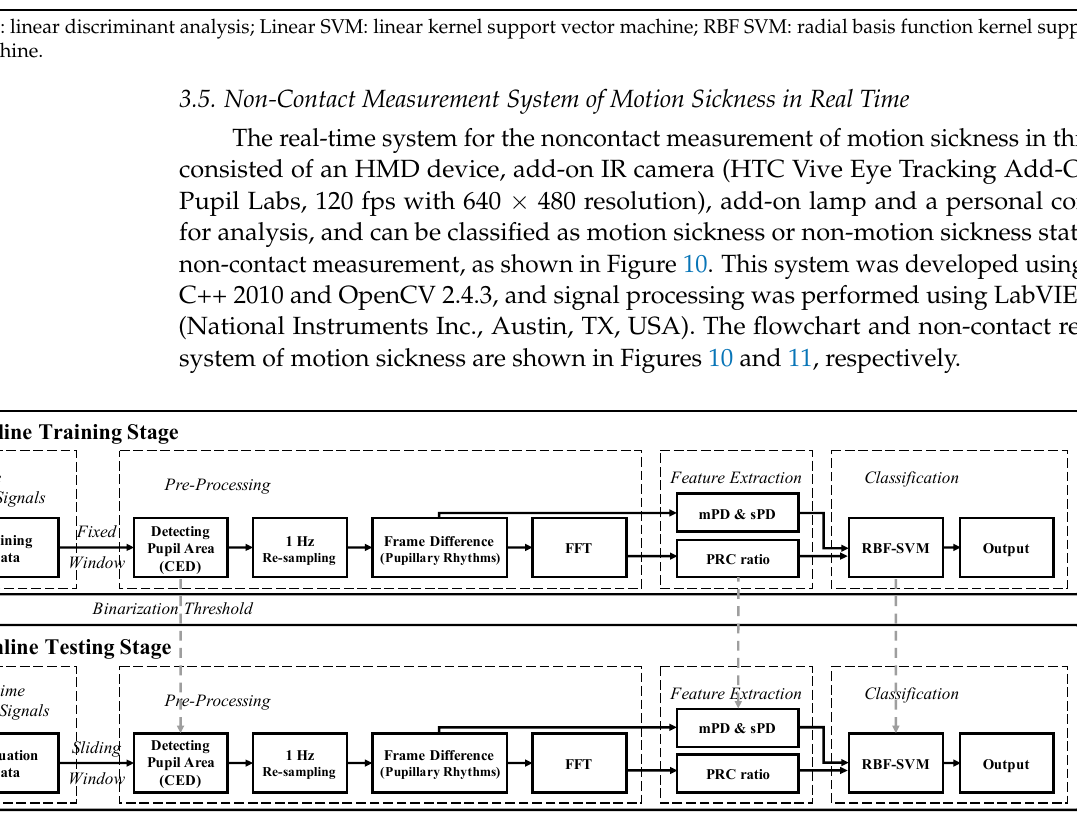
Figure 10. Flowchart for the offline training and online testing stage in the non-contact measurement system of mo- tion